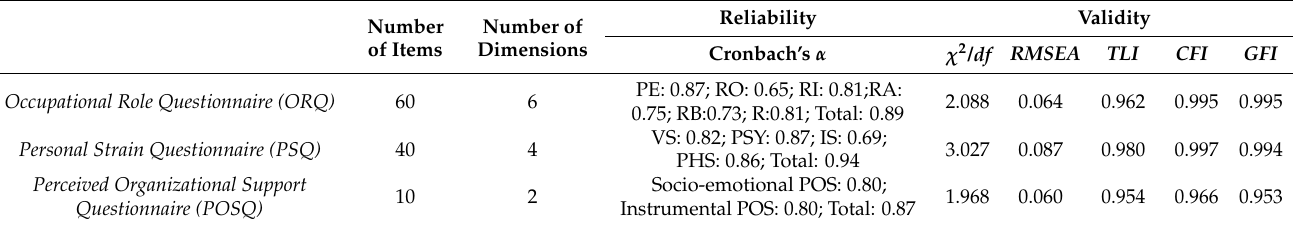
Table 1. Reliability and validity of questionnaires ( N =